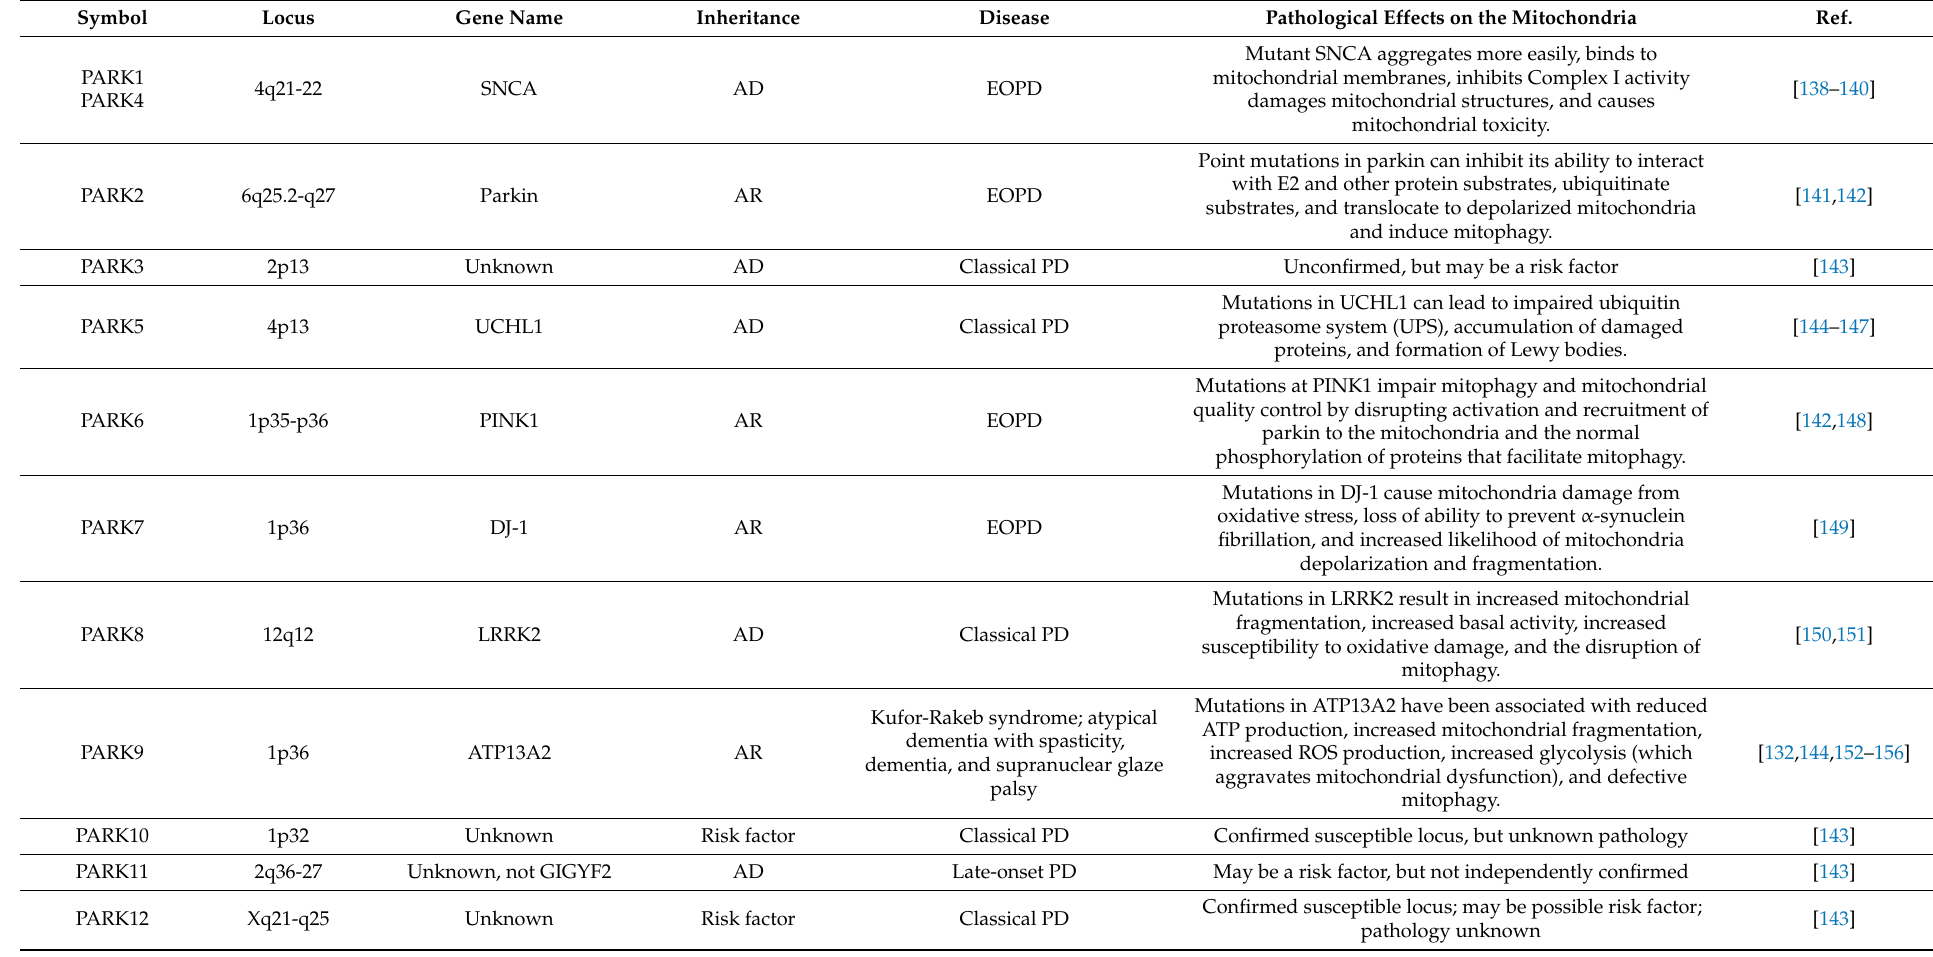
Table 1. PD-associated genes and their functional association with